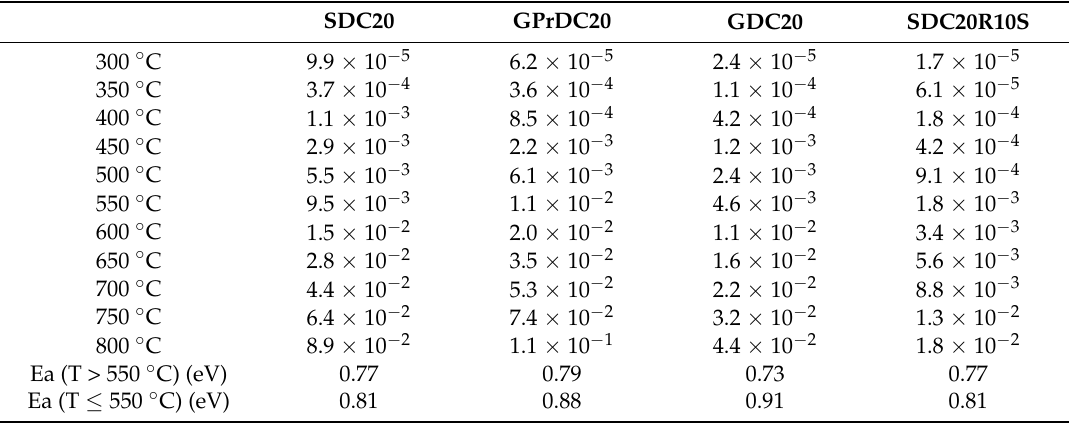
Table 3. Total conductivity and activation energies for sintered electrolytes.